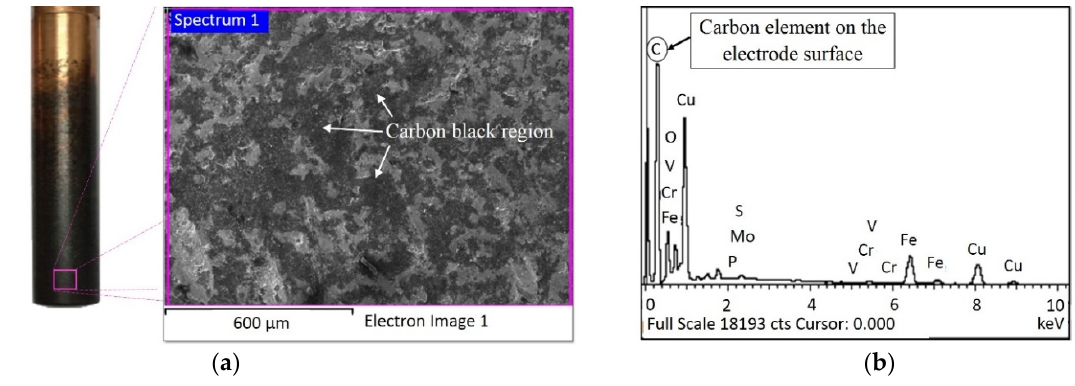
Figure 7. Film-like carbon black on copper electrode: ( a ) SEM micrograph at 40 mm depth, ( b ) energy-dispersive spectrometry (EDS) compositional analysis.